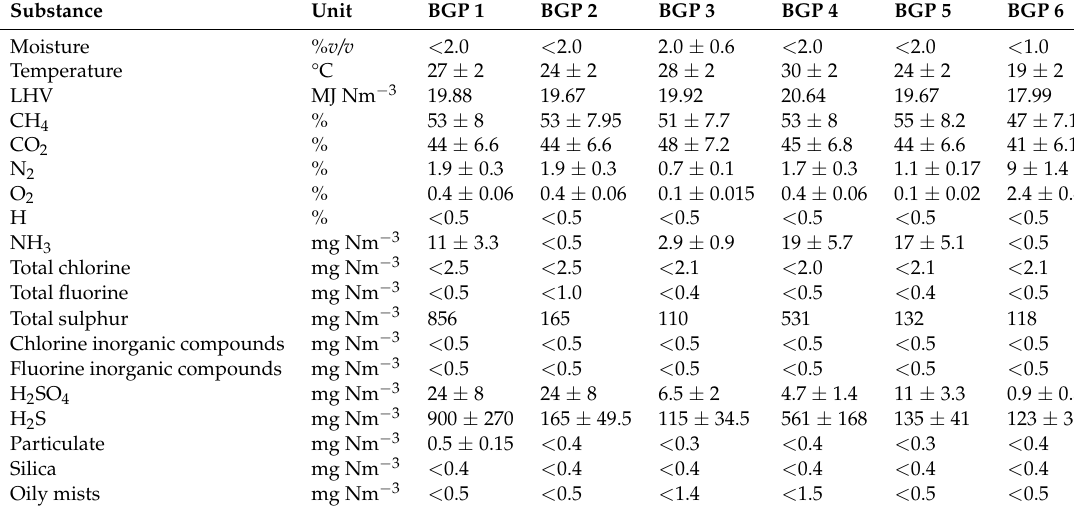
Table 8. Biogas composition—part 1.